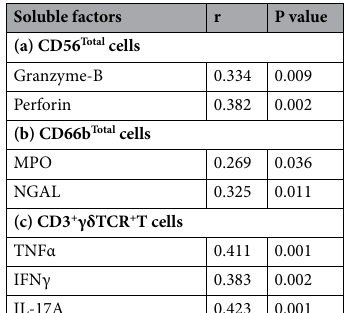
Soluble factors r P